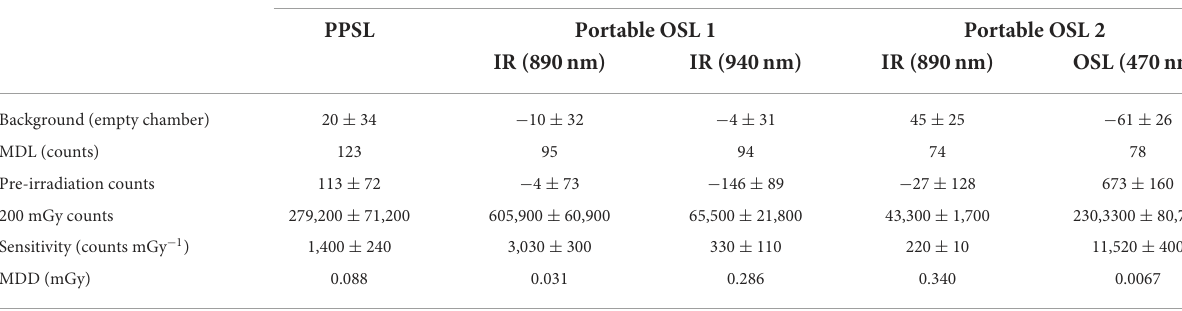
TABLE 1 Photon counts and standard deviation for the background and 200 mGy irradiated salt samples for five sets of measurements on three instruments, with calculated sensitivities and detection limits.